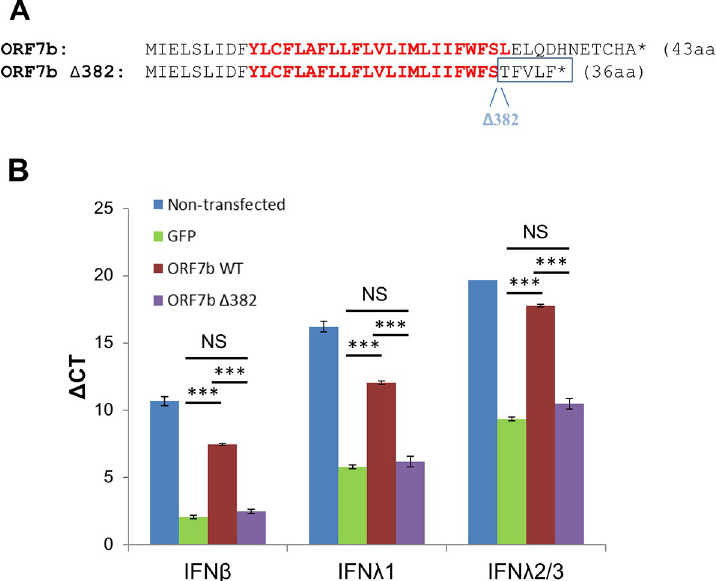
Fig 11. SARS-CoV-2 Δ 382 mutant does not suppress MAVS-induced IFN-production. (A) Alteration of ORF7b protein sequence as a consequence of a 382bp deletion in SARS-CoV-2. The residues in red show the predicted transmembrane domain. The star represents a stop-termination codon. (B) qPCR was performed (as described in Fig 4) comparing MAVS-induced suppression of IFN mRNA levels by wild-type (WT) SARS-CoV-2 ORF7b and mutant ORF7b- Δ 382. Significance was compared to the GFP positive control, ��� P < 0.0001. NS—not significant.